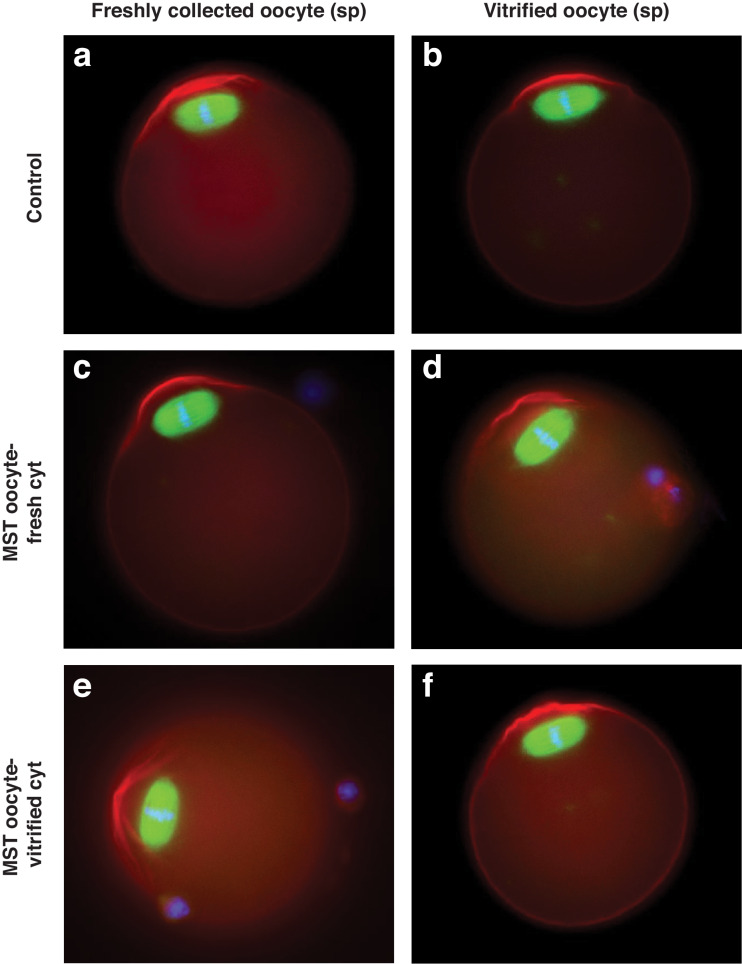
Representative immunofluorescence images of B6CBAF1 strain fresh (left) or vitrified (right) oocytes that have been non-manipulated (control) or used as spindle (sp) donors for MST procedures.Microfilaments of actin are labeled in red, tubulin in green and DNA in blue.